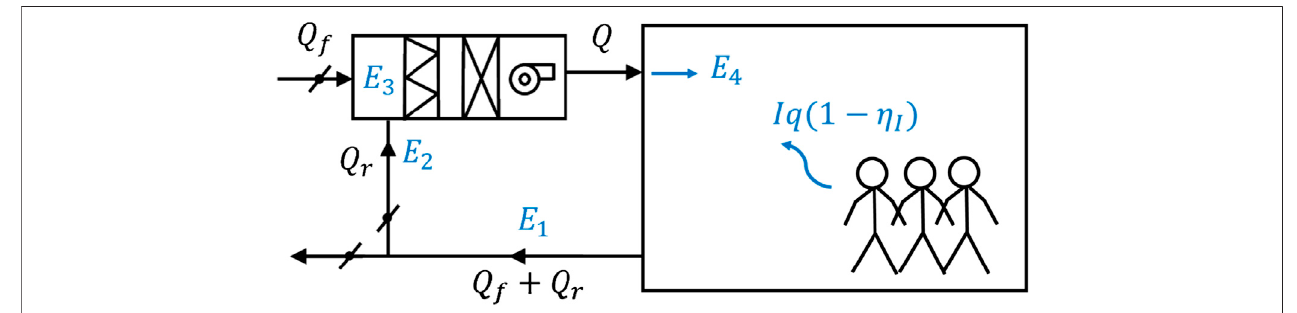
FIGURE 1 | Distribution of quanta rate in a primary return air